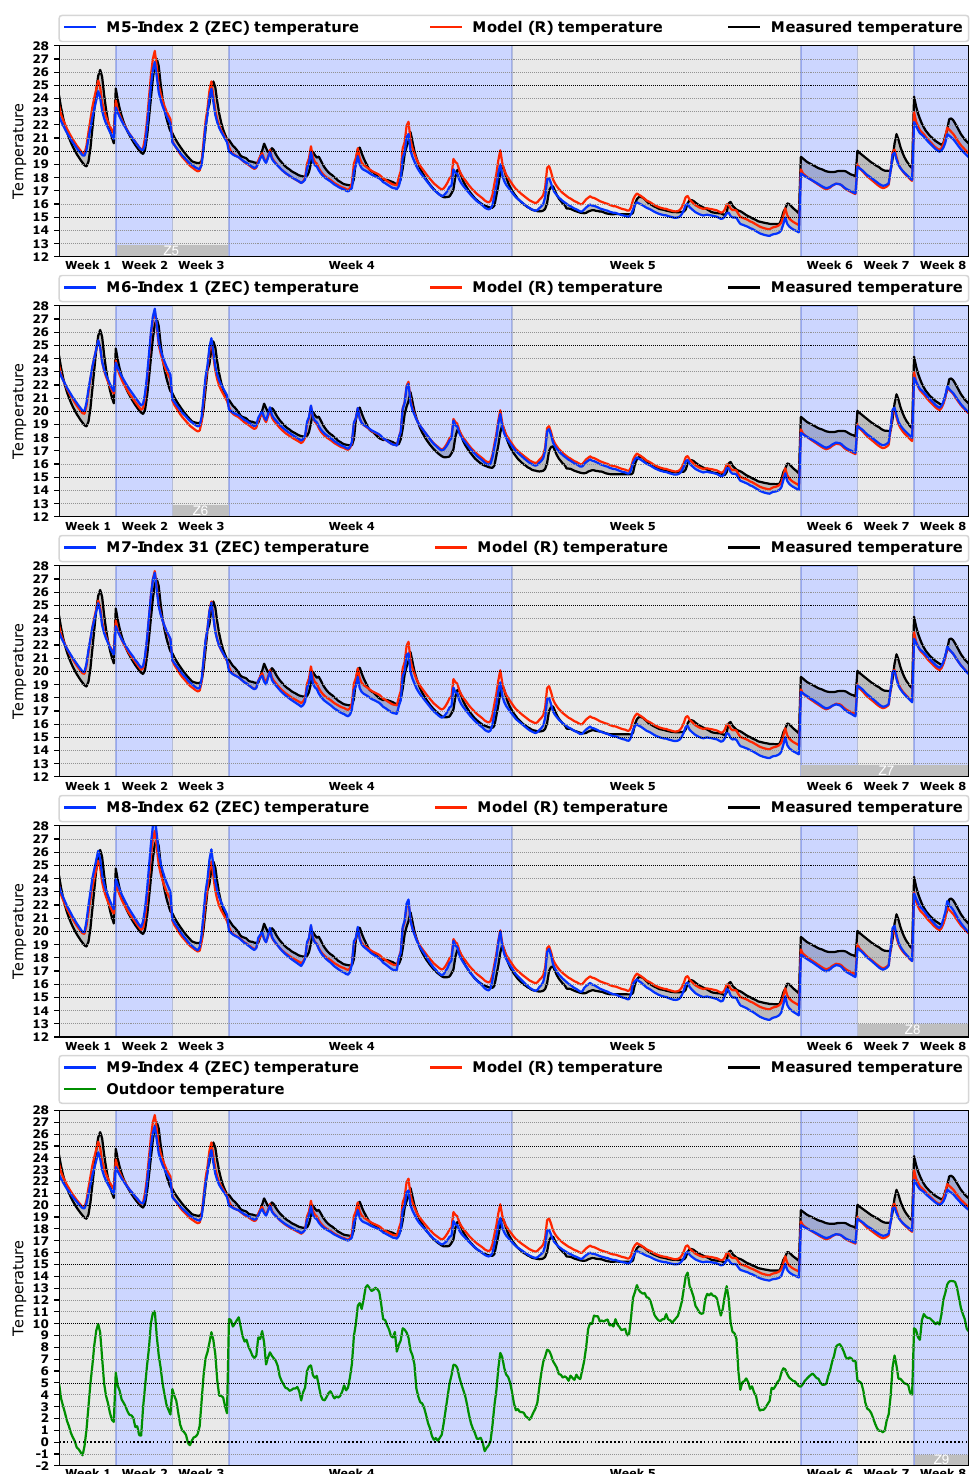
Figure 8. Temperature time series between the two calibration